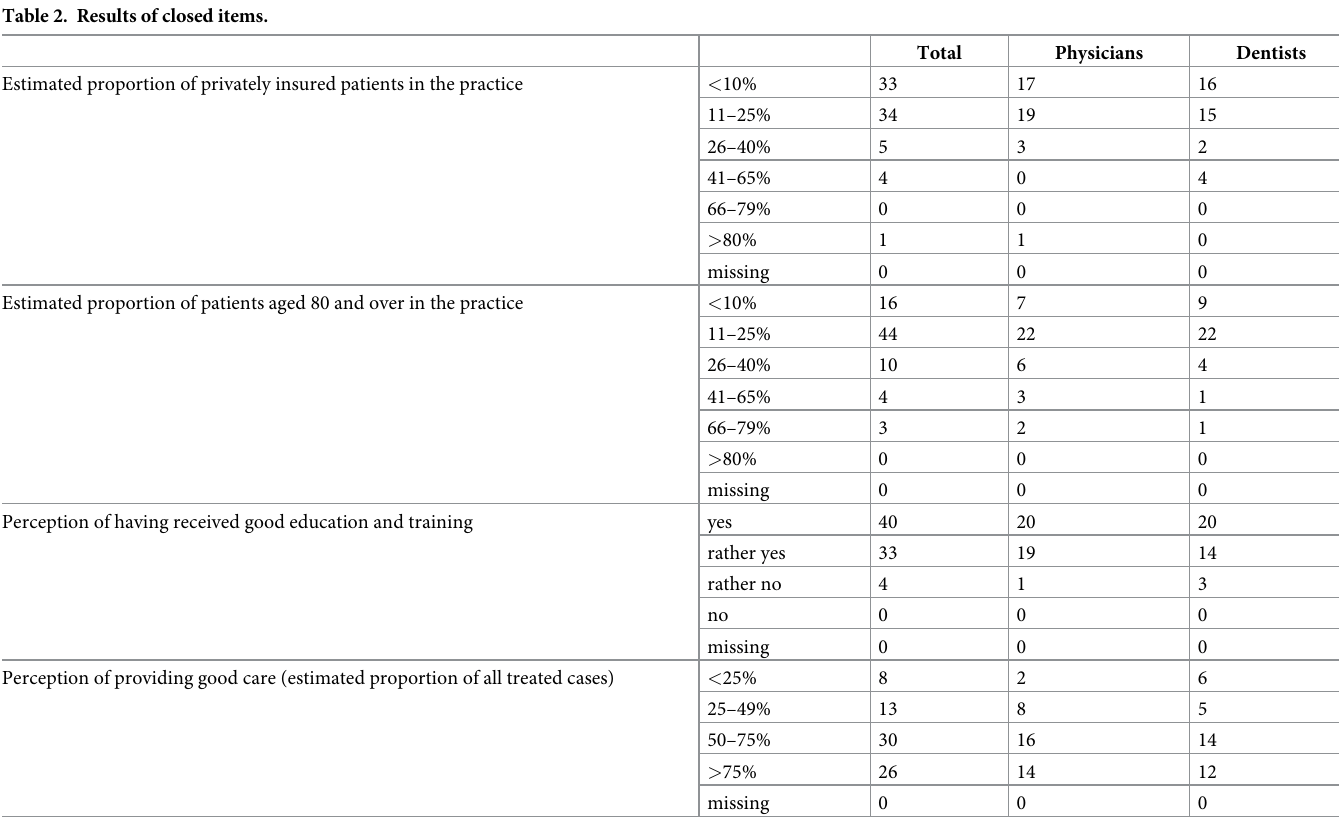
Table 2. Results of closed